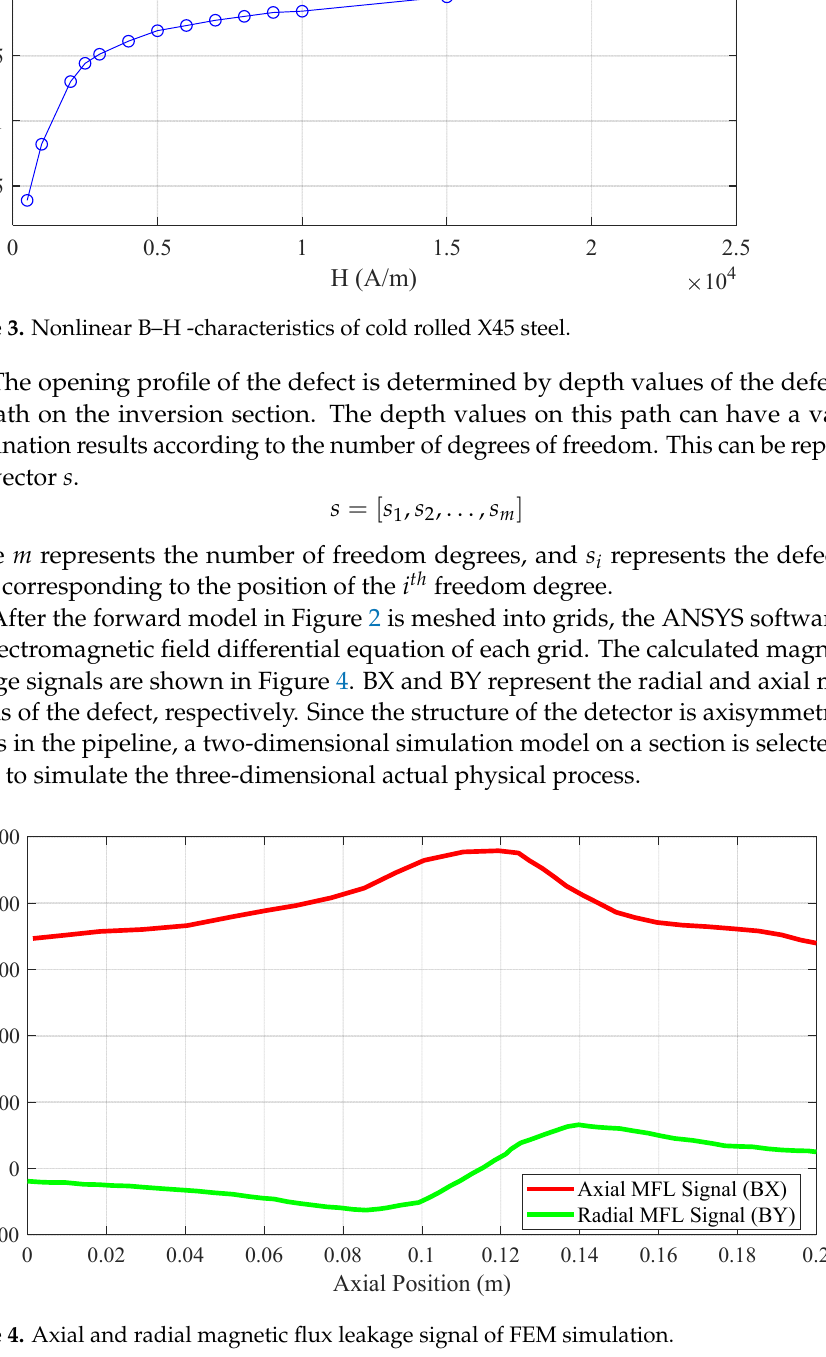
4 of 15 Table 1. Properties of the finite ‐ element simulation model. Components